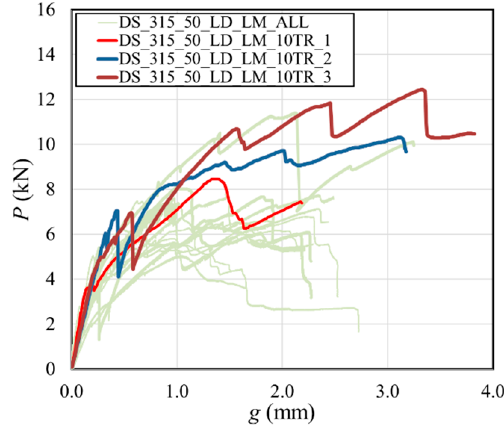
Figure 8. Comparison of load response of SRG-masonry joints tested with two test rates.